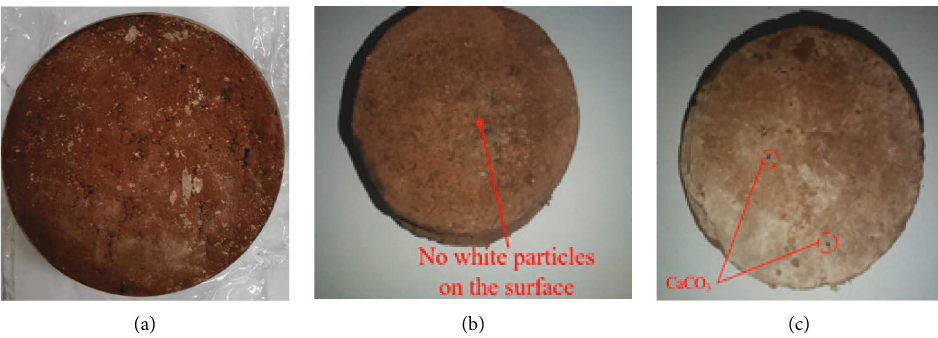
Figure 4: Comparison of MICP-treated root-soil composites. (a) Root-soil composites before MICP-treated; (b) root-soil composites without MICP-treated; and (c) root-soil composites after MICP-treated.